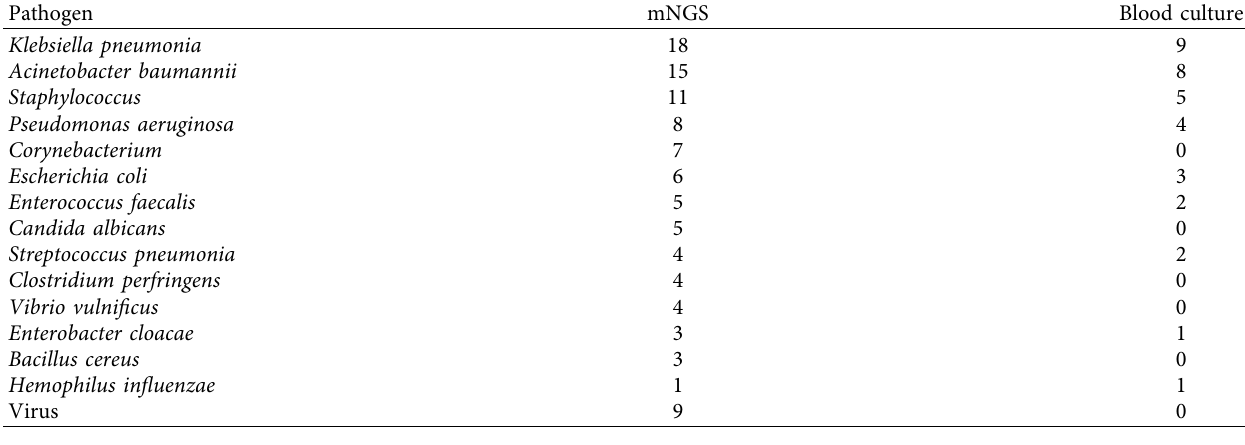
Table 7: Microbial diversity detected by mNGS.